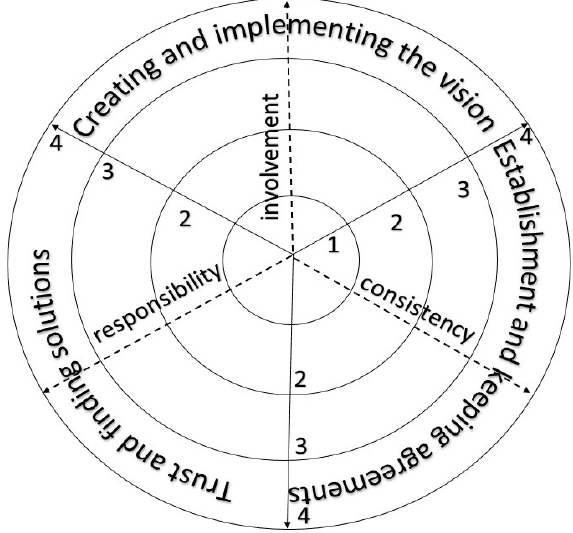
Fig. 1. 3C model “Coaching Culture Characteristics in Leadership